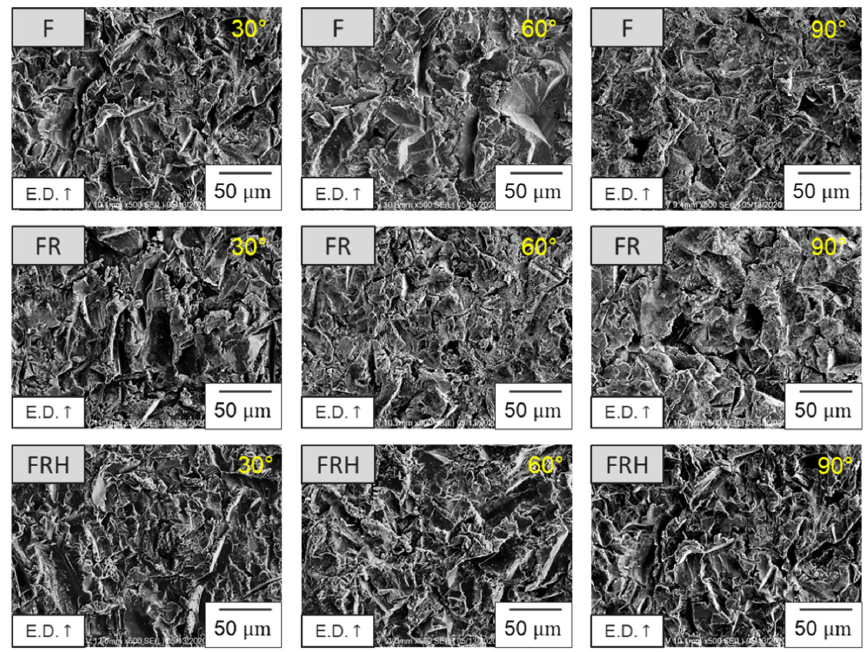
Figure 7. The SEM morphology of the erosion surface.